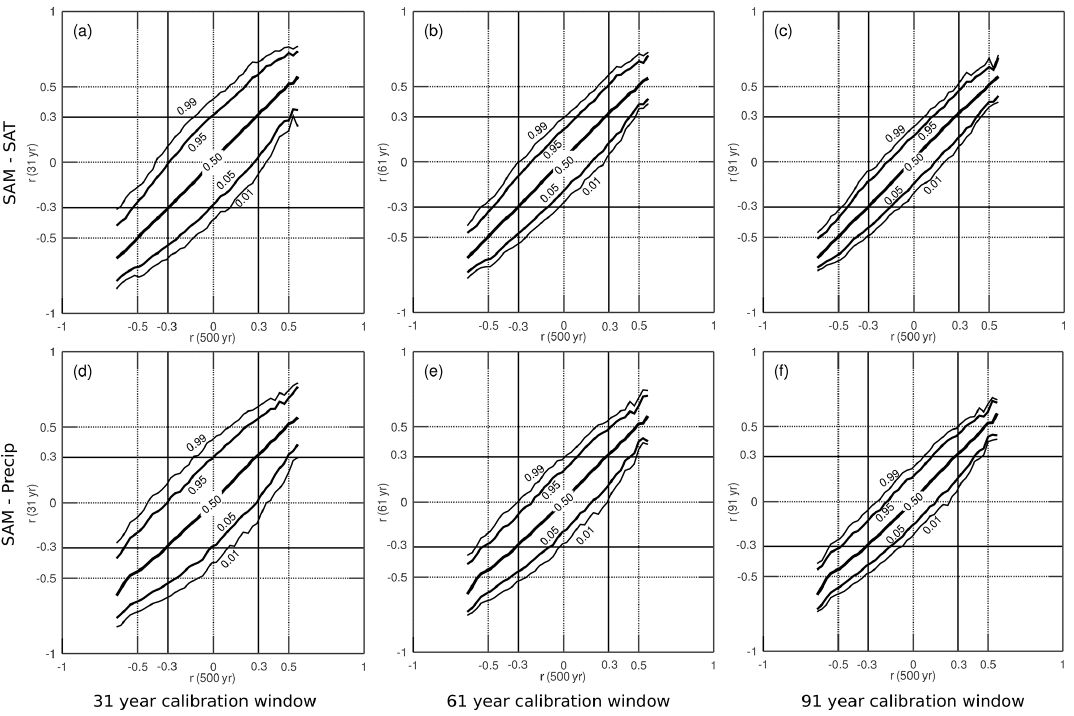
Figure 2. Correlation coefficients between the model SAM index and both SAT (a, b, c) and precipitation (d, e, f) fields. Panels show the probability distribution of a grid point with a certain probability in a 31 year (a, d) , 61 year (b, e) , and 91 year (c, f) calibration window given the same point’s correlation over the full 500 years. This illustrates how a longer calibration window will ensure that the correlation of a point to the SAM within that window will be closer to the “true” correlation calculated over the full 500